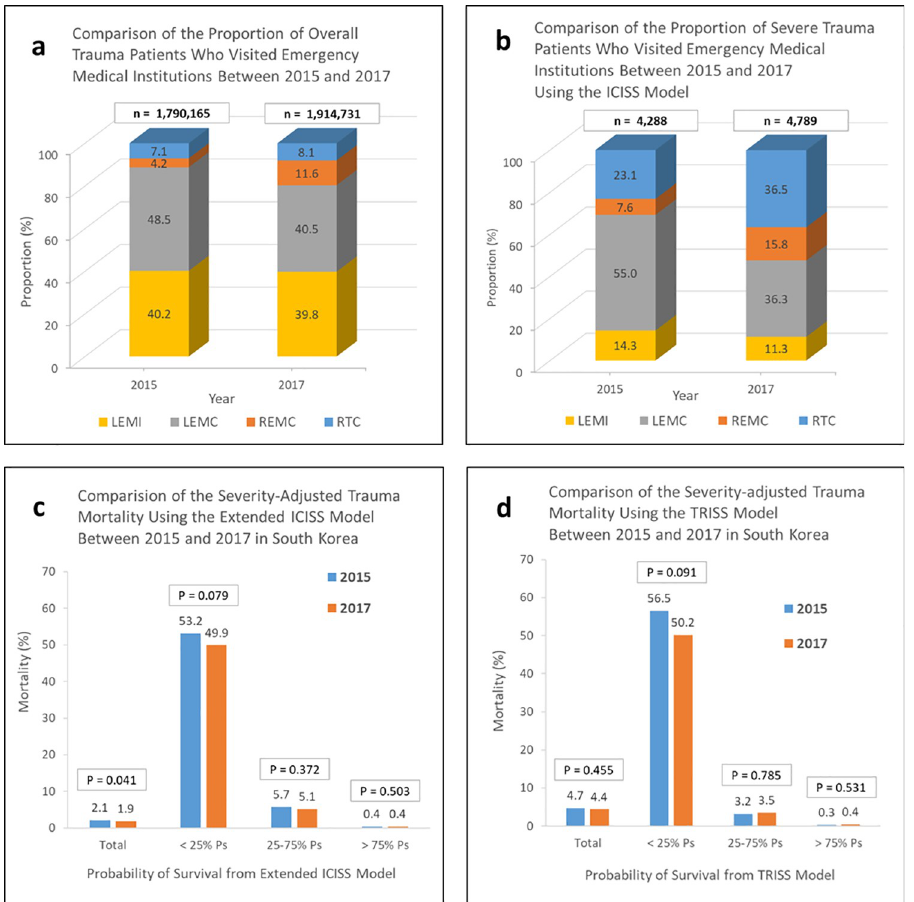
Fig 5. Changes in performance and outcomes of trauma patients between 2015 and 2017. (a) and (b) are based on the ICISS model targeted to all emergency medical institutions in South Korea. (c) shows the results of the severity- adjusted trauma mortality model using an extended ICISS model targeted for emergency medical institutions other than LEMIs. (d) is a TRISS model resulting from data registered by RTCs. RTC, Regional Trauma Center; REMC, Regional Emergency Medical Center; LEMC, Local Emergency Medical Center; LEMI, Local Emergency Medical Institution; ICISS, International Classification of Disease Injury Severity Score; TRISS, Trauma and Injury Severity Score; Ps, probability of